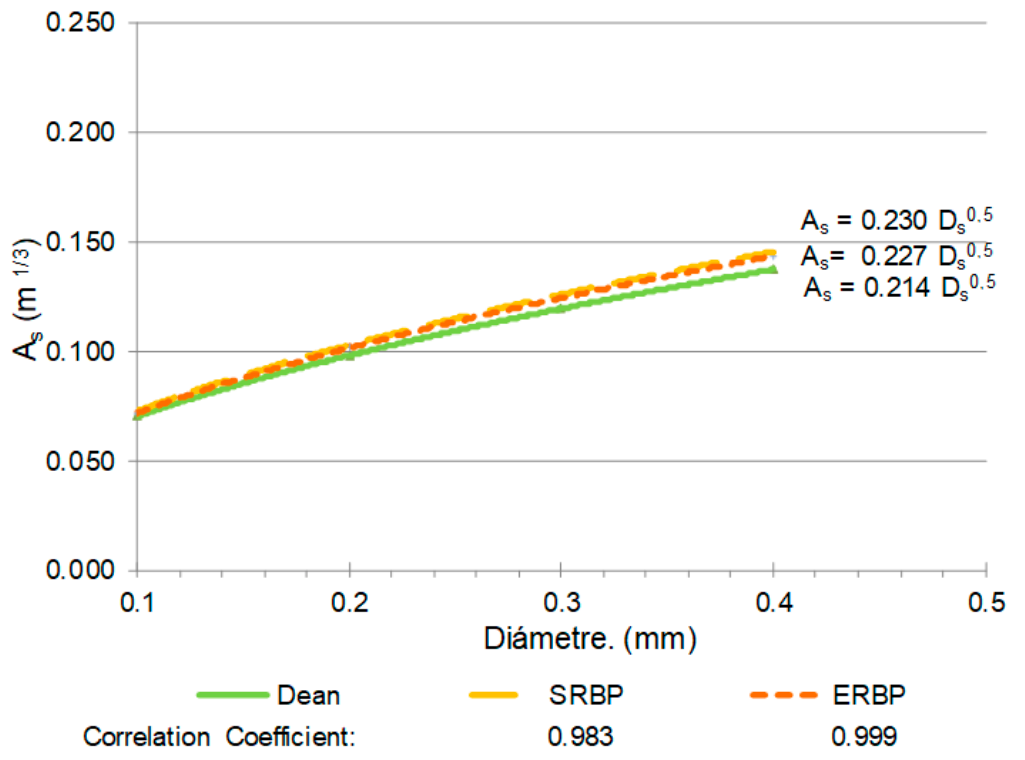
Figure 7. Relationship between the shape parameter of the submerged parabola vs. the average submerged diameter for the two different types of profile (only ERBP and SRBP; obviously, the mono-parabolic type does not have any submerged parabola). Comparison with Dean’s formula.